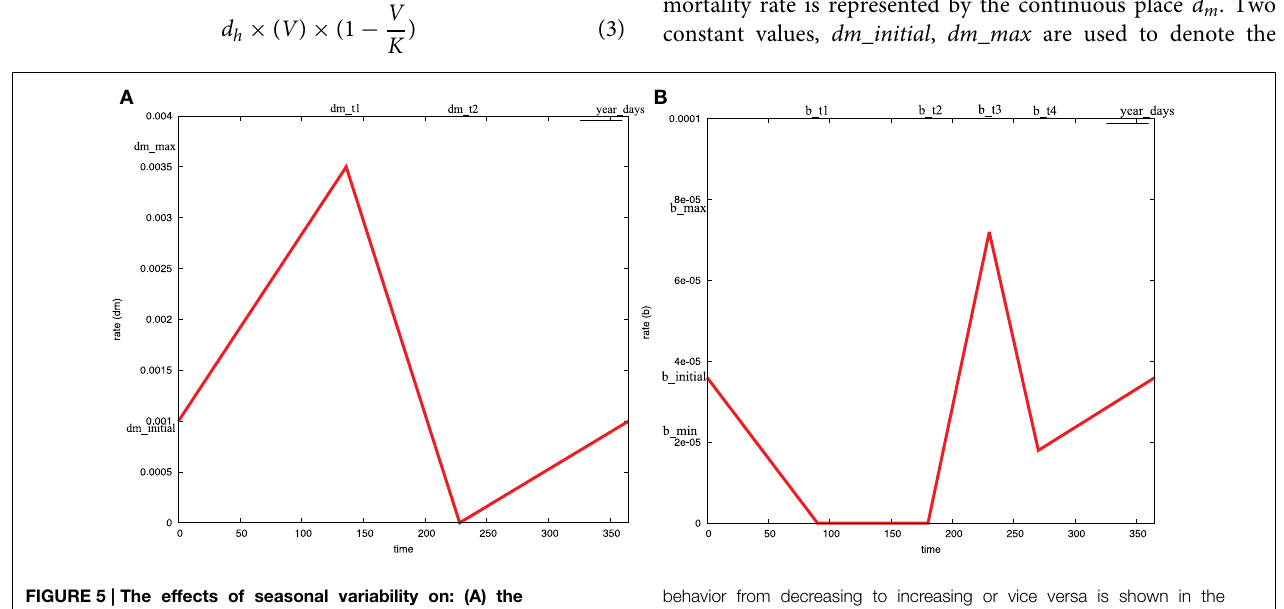
behavior from decreasing to increasing or vice versa is shown in the x-axis. The exact time points where the functions change their behavior is illustrated in the upper axis. Similarly, the start and end values of each piece is shown in the y-axis. The exact values of these parameters are given in the Supplementary